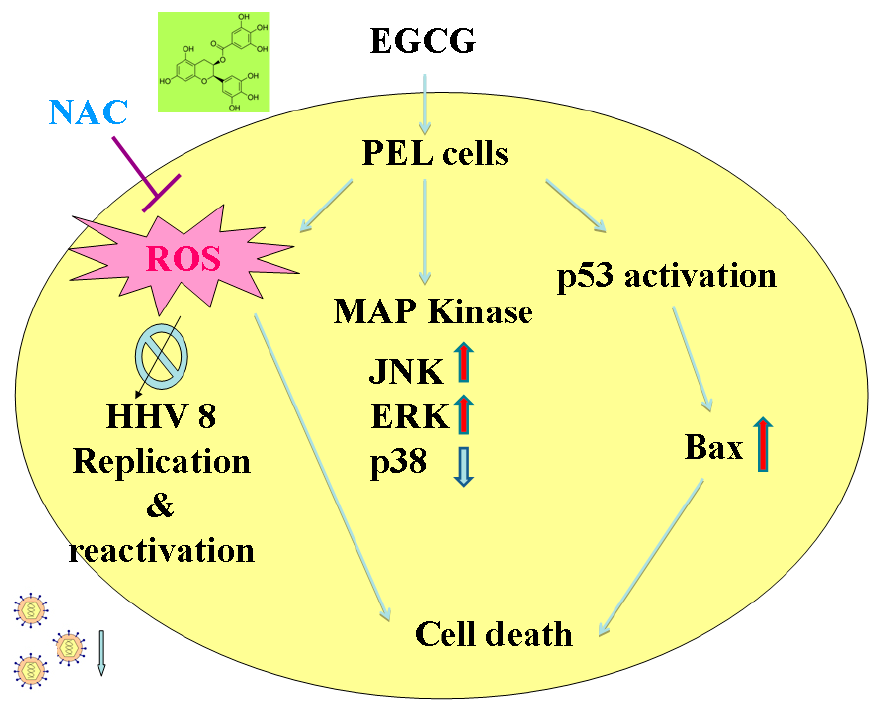
Figure 8. Schematic summary of EGCG-induced cell death in HHV8-harboring PEL cells.